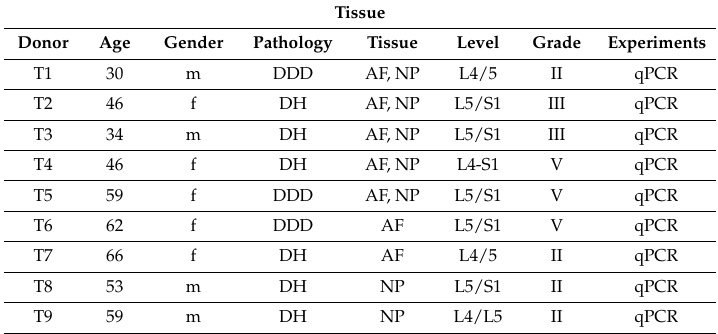
Table 3. Donors used for tissue and cell culture analyses. DH = herniation, DDD = degenerative disc disease, AF = annulus fibrosus, NP = nucleus pulposus, uk =